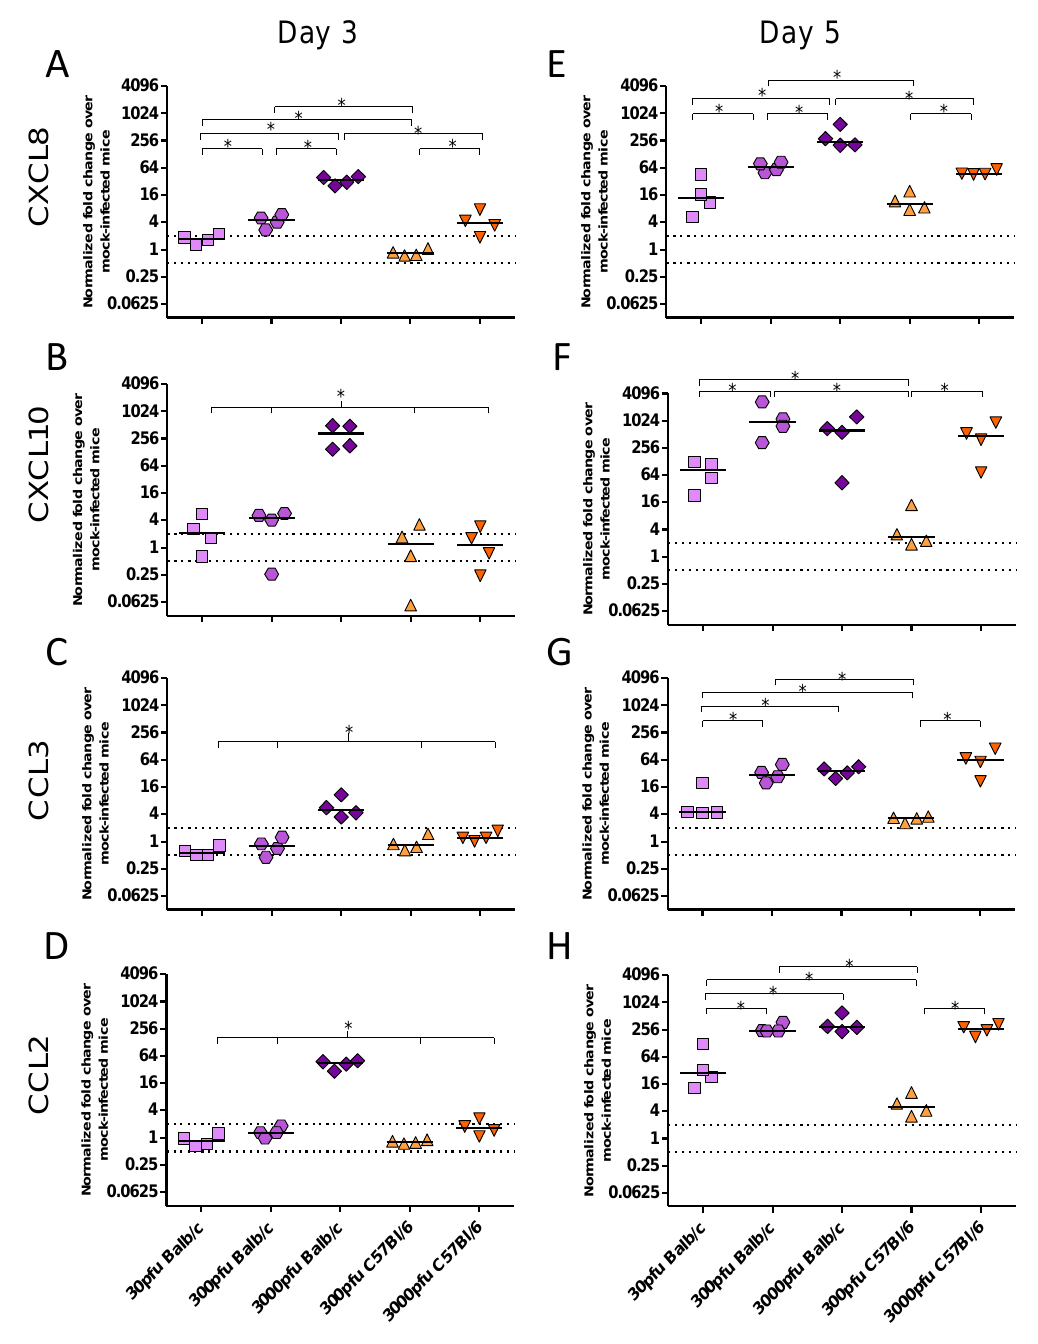
Figure 4. Chemokine expression by Balb/c and C57Bl/6 mice following infection with PVM 15. Five to six week-old Balb/c and C57Bl/6 mice were inoculated with medium, 30 pfu, 300 pfu, or 3000 pfu of PVM 15 and lungs were collected from four mice per group on days 3 ( A – D ) and 5 p.i. ( E – H ). The expression levels of CXCL8 ( A and E ), CXCL10 ( B and F ), CCL3 ( C and G ), and CCL2 ( D and H ) were calculated using the Bio-Rad analysis software (Bio-Rad CFX Manager Version 2.0), normalized against the expression of both β-actin and GAPDH housekeeping genes, and expressed as the normalized fold-change over mock-infected control animals euthanized on the same day p.i.. Each data point represents a single animal and the line represents the group median. *, p